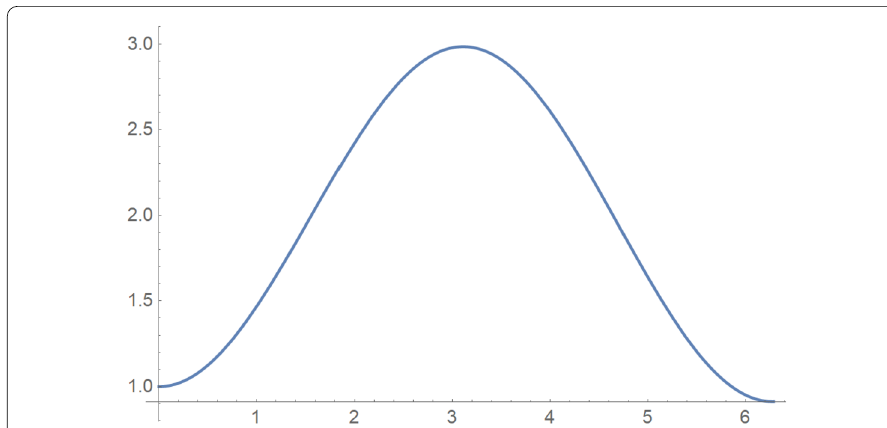
Figure 6 Solution of the problem for α = 0.99